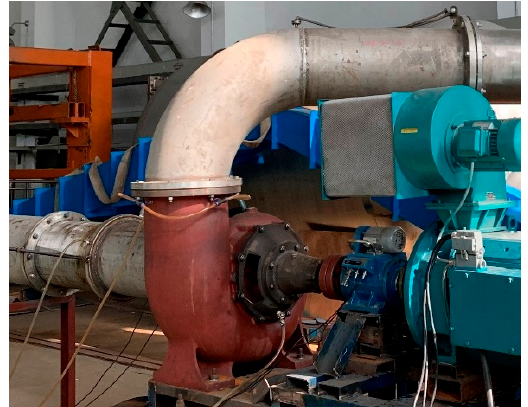
Figure 4. Test bench of a mixed-flow pump with a volute.